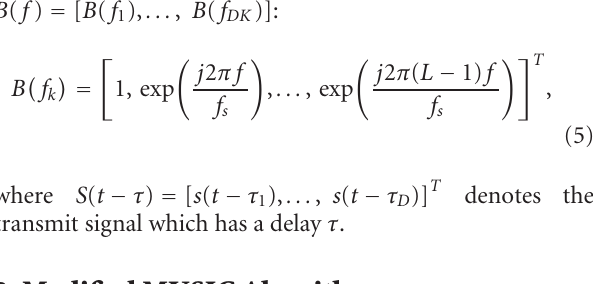
algorithm. The flow chart of the modified MUSIC